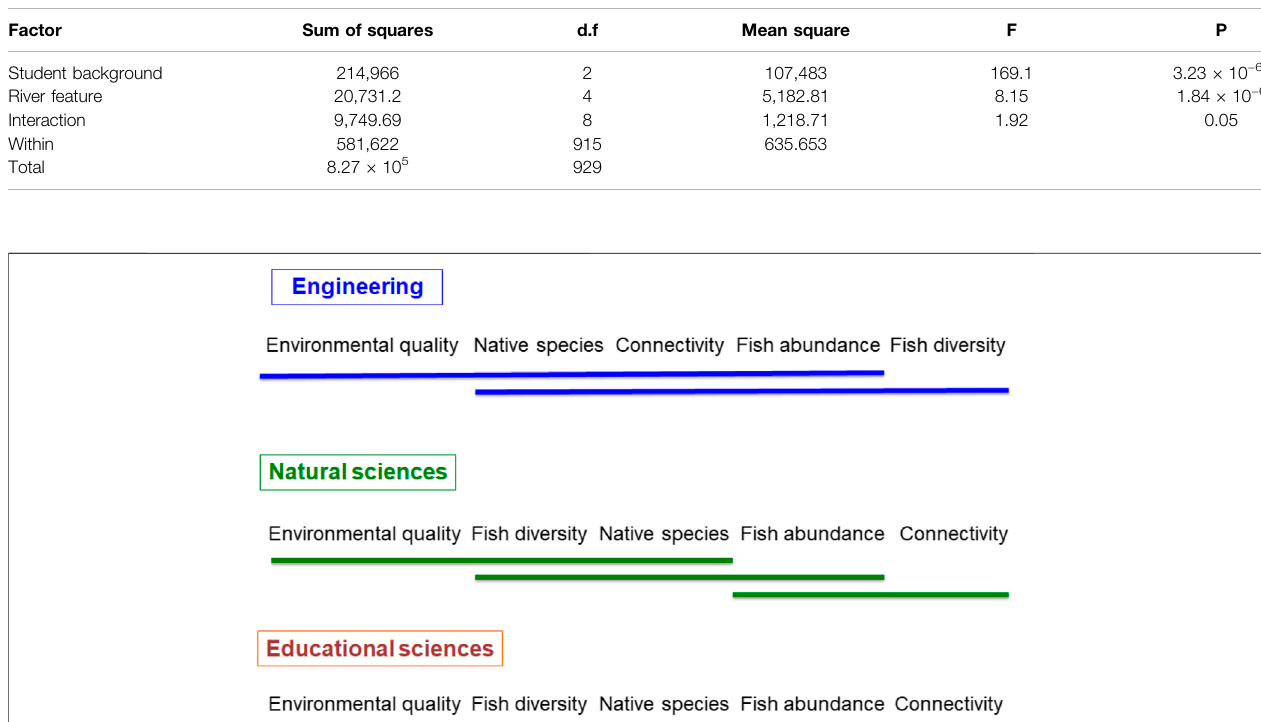
Frontiers in Environmental Science |